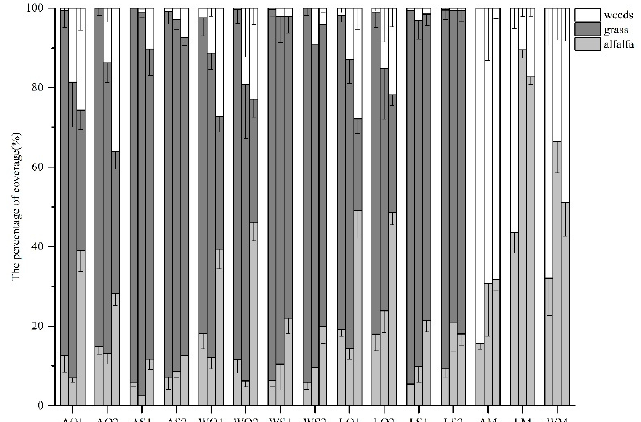
Figure 2. The percentage of coverage among all treatments during the growing season (mean ± SE).